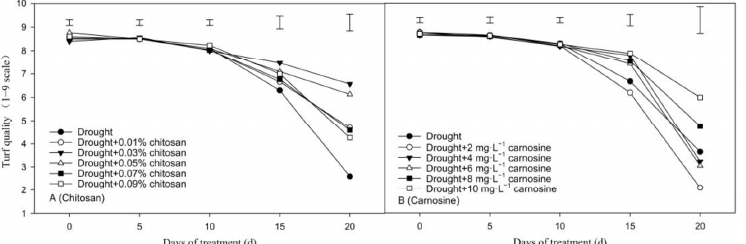
Figure 1. Effects of different concentrations of carnosine or chitosan on turf quality under drought stress in bermudagrass. ‘Drought’ represents plants without foliar application of any chemicals but only sprayed with distilled water. Vertical bars represent LSD values where a significant difference ( p < 0.05) was detected among different treatments at the same time point.